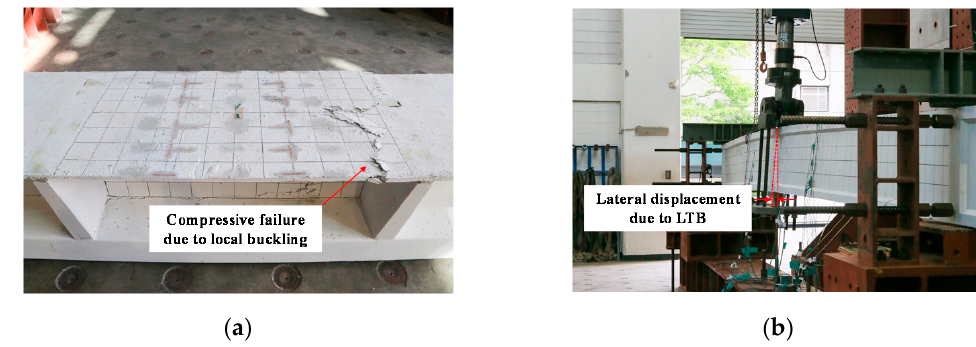
Figure 2. Examples of buckling failure in concrete slender members: ( a ) local buckling of thin-walled ultra-high performance concrete (UHPC) flanges (a test specimen conducted from reference [22]) and ( b ) lateral-torsional buckling (LTB) of slender UHPC I-girder (test specimen conducted from reference [21]).